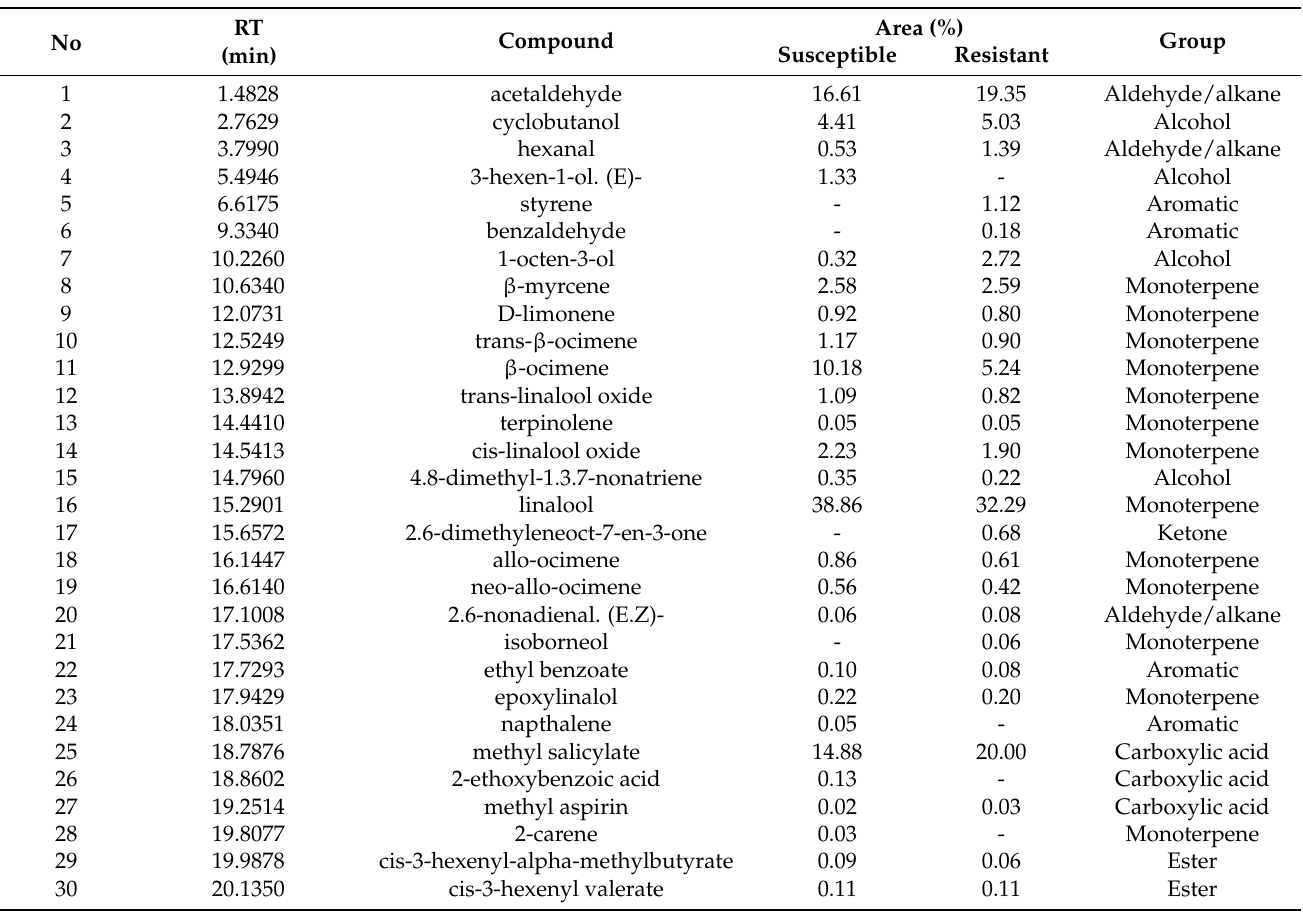
Table 1. The volatile compounds produced by the tea clones and the chemical groups they belong to. Compounds that are important in the resistance or susceptibility of the clones to the leafhopper E. flavescens are